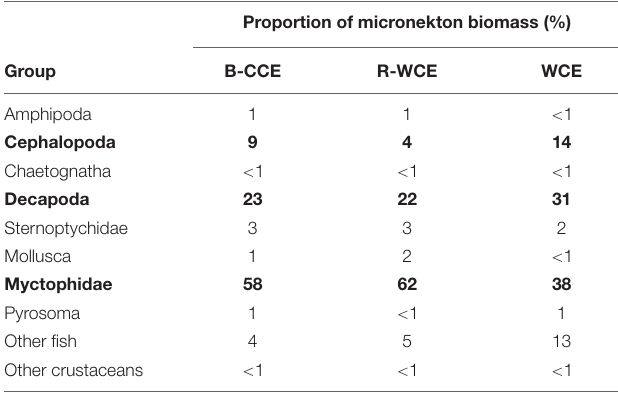
TABLE 2 | Proportion of micronekton carbon biomass by major taxonomic group captured in the MIDOC. Proportion of micronekton biomass